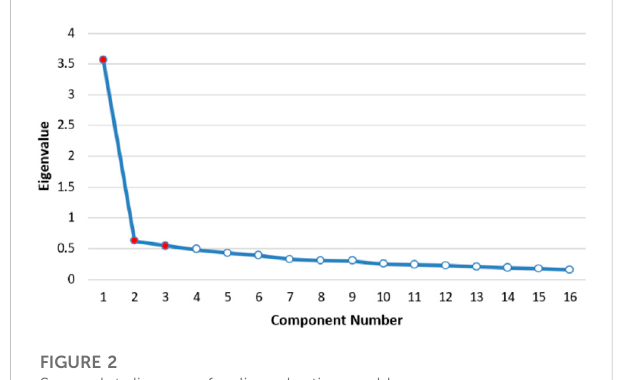
FIGURE 2 Scree plot diagram of policy adoption enablers.